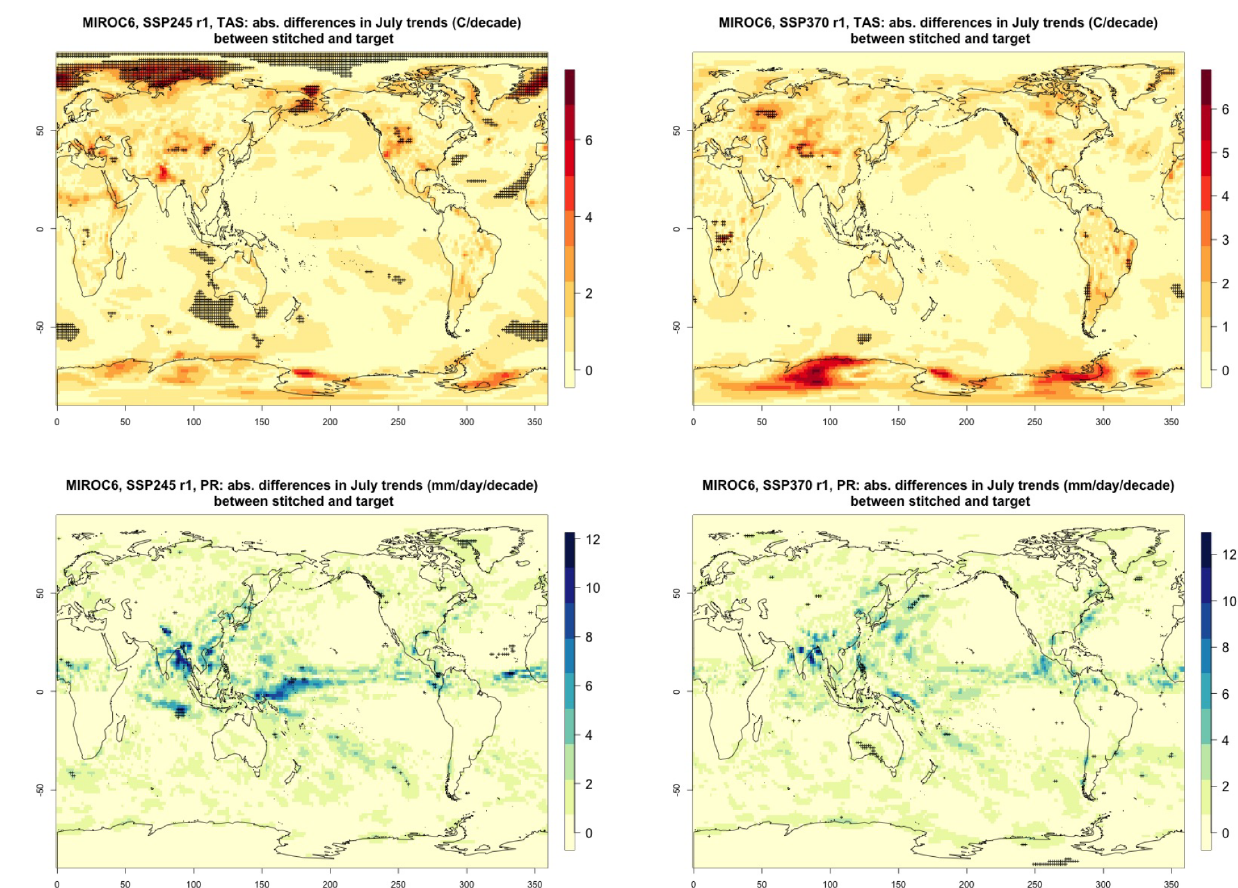
Figure C7. Absolute difference in decadal trends of July temperature (TAS) and precipitation (PR) between stitched and target realizations. The value of the difference is expressed by the color scale, and we marked as significant with black crosses those locations where the 95% confidence intervals of the trends computed from target and stitched time series do not overlap, indicating statistically significant differences. Emulation of MIROC6, July time series over 2015–2100, for SSP2-4.5 and SSP3-7.0. First realization.